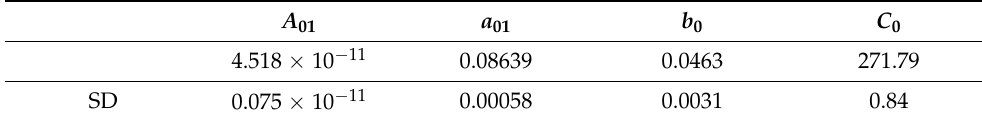
Table 2. The coefficients for Equation (4) generalized to